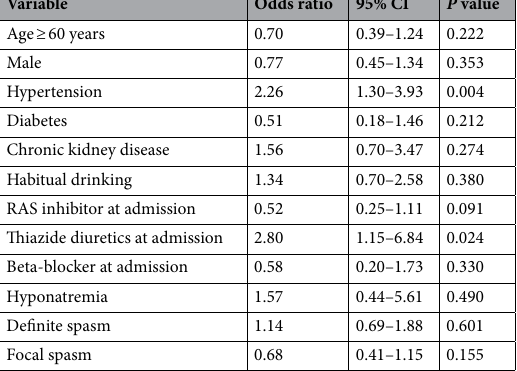
Table 2. Predictors of hypokalemia in patients with vasospastic angina. RAS renin-angiotensin system.